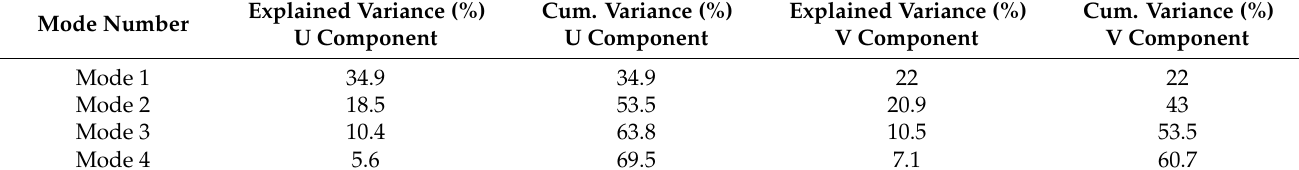
Table 7. The fraction of variance retained by the first 4 EOF modes and the cumulative variance.